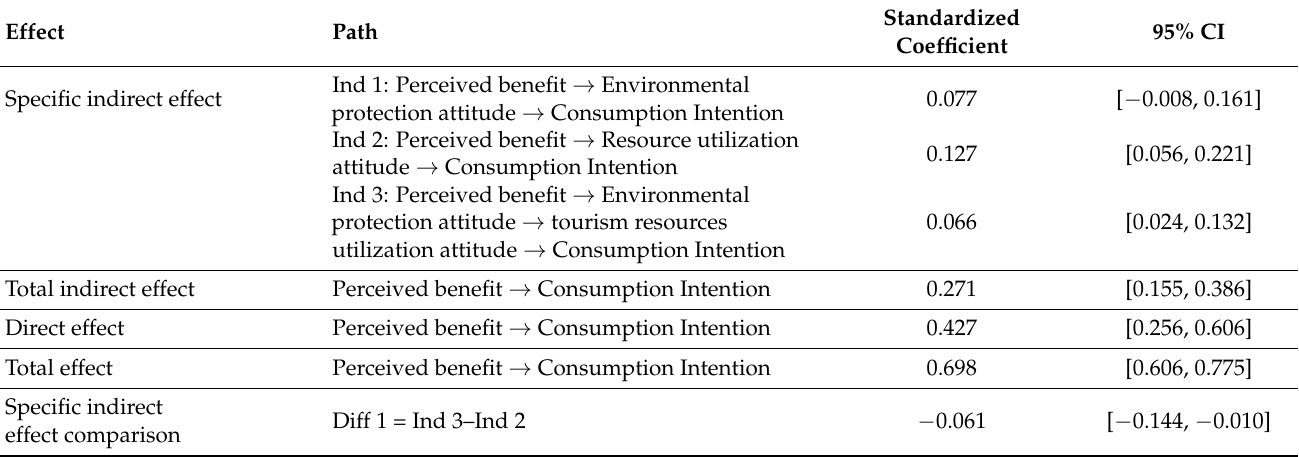
Table 3. Mediating effect